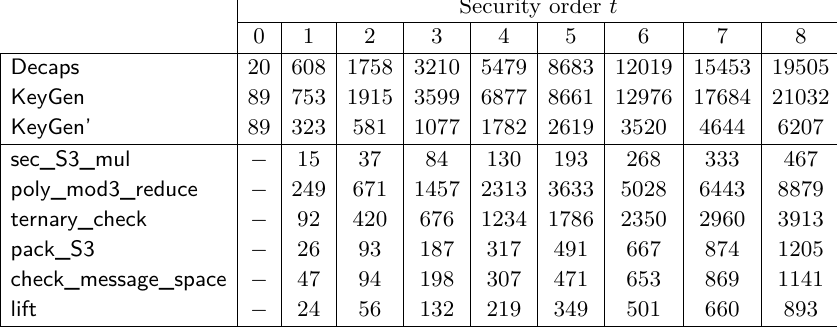
Table 8: Cycle counts for key generation, decapsulation and main gadgets for the optimized AVX2 version of ntruhps2048509 , in thousands of